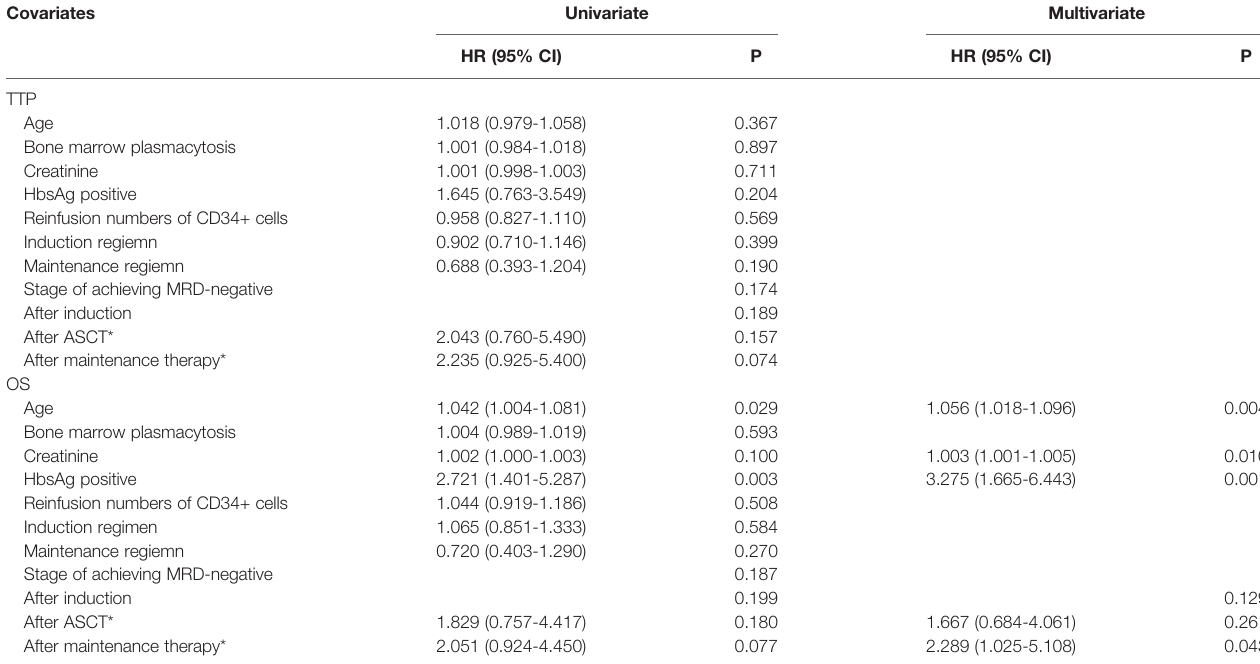
TABLE 4 | Univariate and multivariate analyses of TTP and OS for patients with R-ISS I-II.